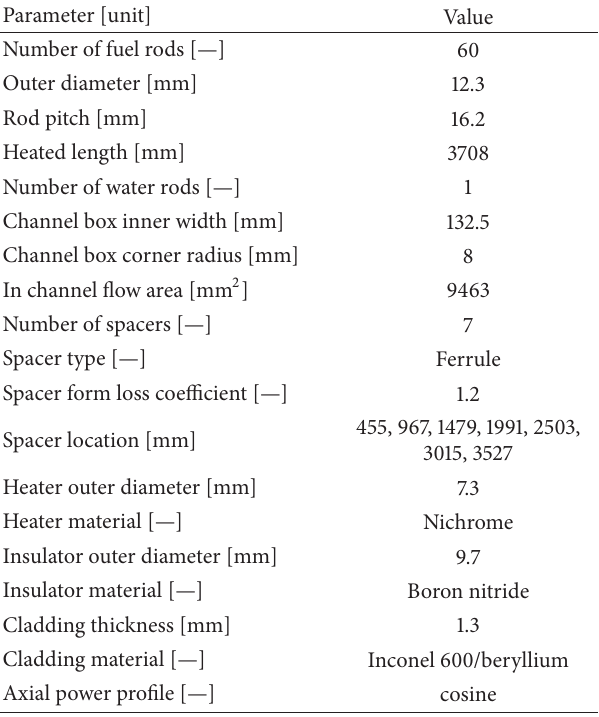
Table 1: Main features of assembly